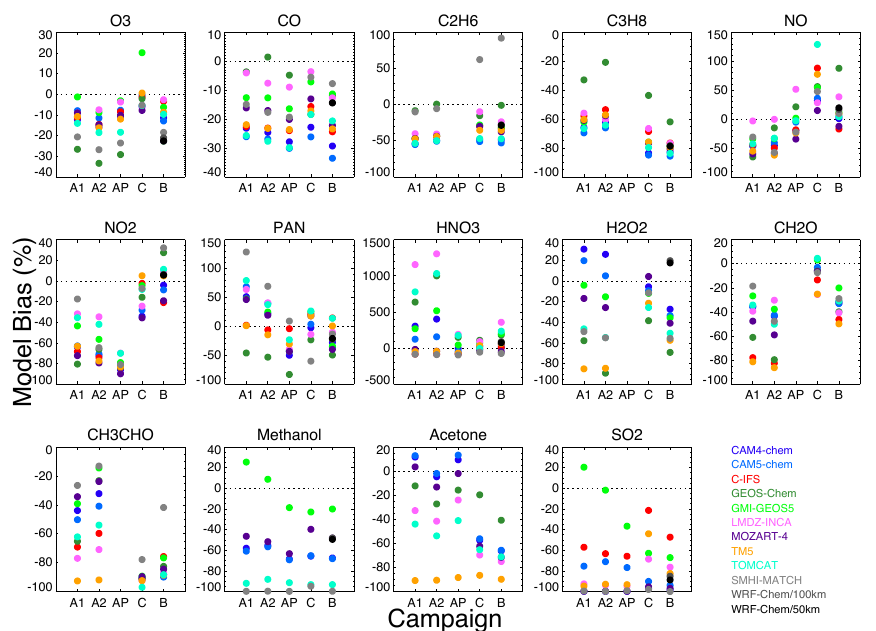
Figure 19. Mean bias (%) between models and aircraft observations, averaged over 3–7km. Bias for multiple measurements of a single compound are also averaged over each campaign, which are A1: ARCTAS-A 4–9 April; A2: ARCTAS-A 12–17 April; AP: ARCPAC 11–21 April; C: ARCTAS-CARB 18–24 June; and B: ARCTAS-B 29 June–10